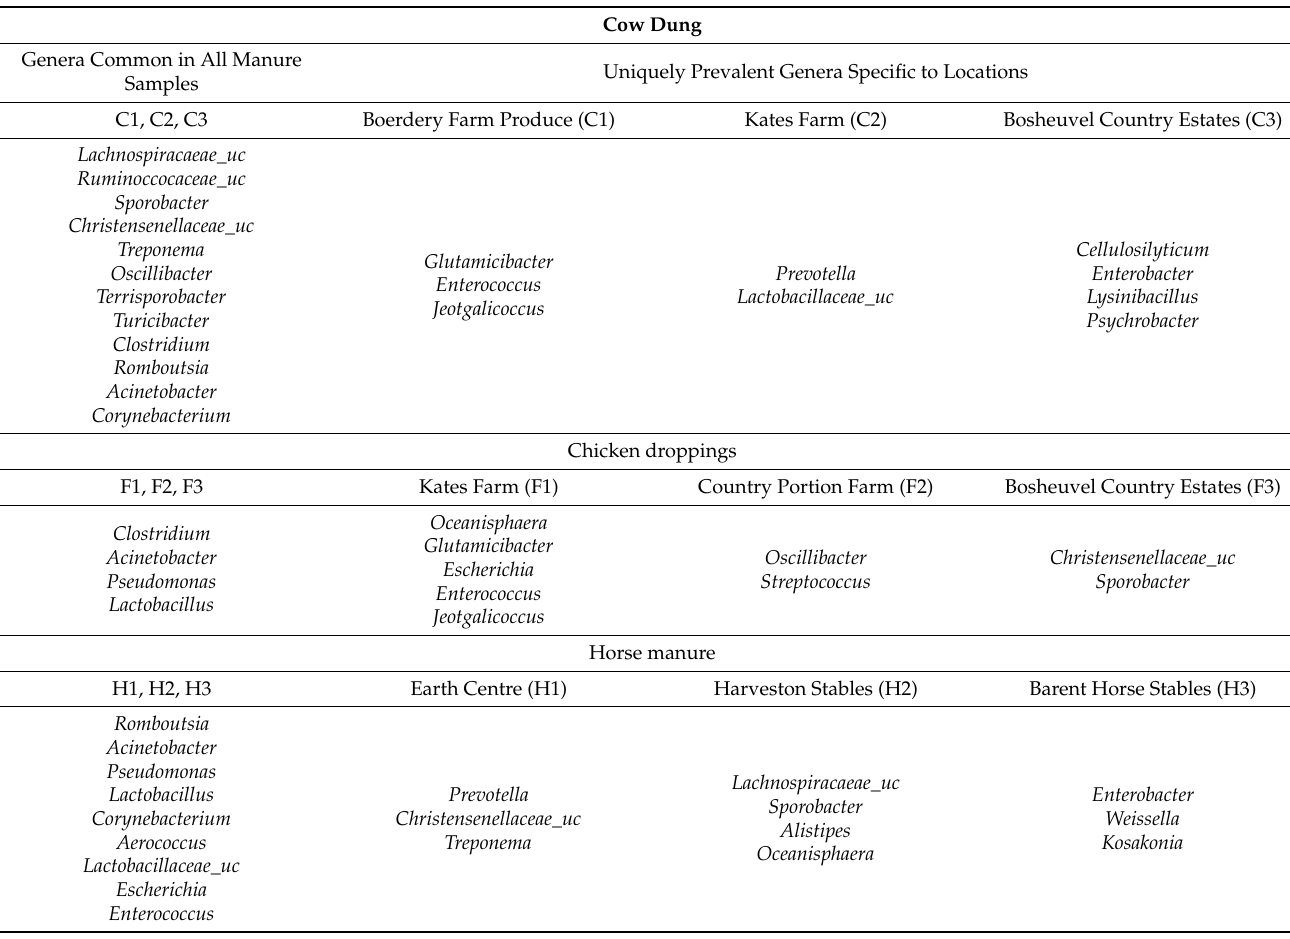
Table A3. Genera prevalent in various manure samples from various